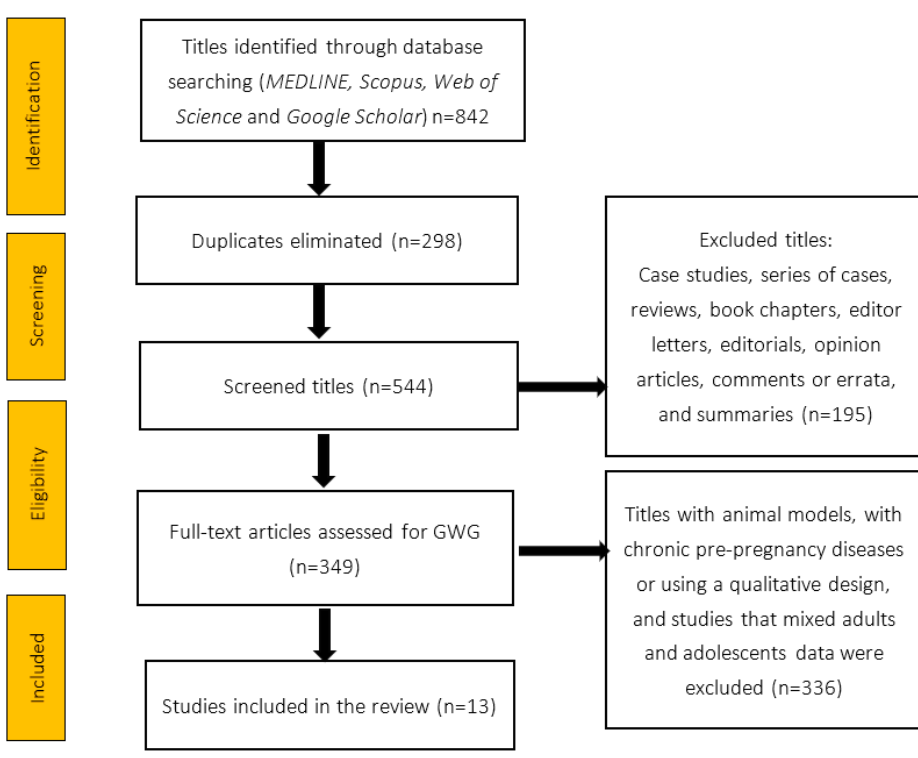
Figure 1. PRISMA flow diagram used for selecting the